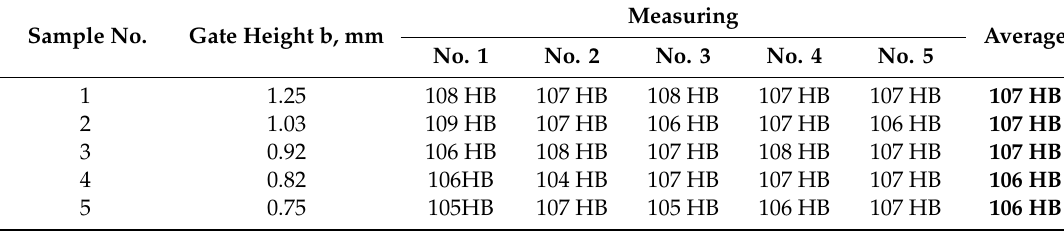
Table 5. Values of surface hardness of casting